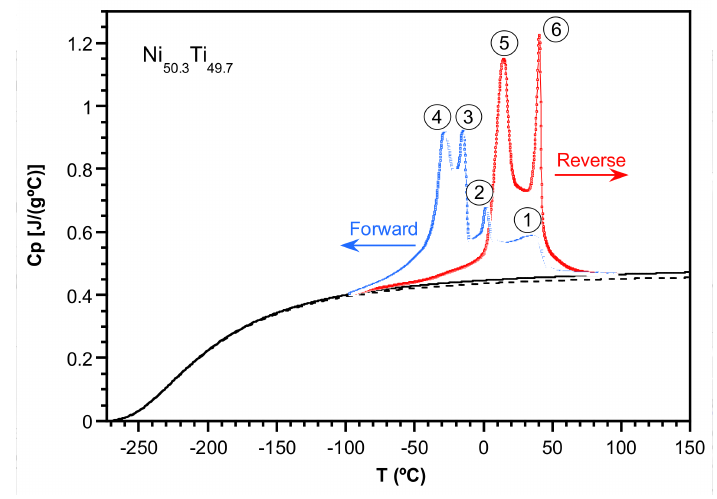
Figure 2. The Ni 50.3 Ti 49.7 specific heat, once stabilized after 75 thermal cycles. Both the forward ( (cid:3) : blue) and reverse (o: red) martensitic transformations are shown. The encircled numbers indicate each MT stage. The continuous line is the calculated lattice contribution to C p . The dotted line is the harmonic specific heat ( C h ). The differences between these two curves represent the anharmonic contribution ( C anh ). Table 1. C p peaks, temperature ( T p ( ◦ C)), transformation stages, and partial and total martensitic transformation MT enthalpy values ( ∆ H ) after 75